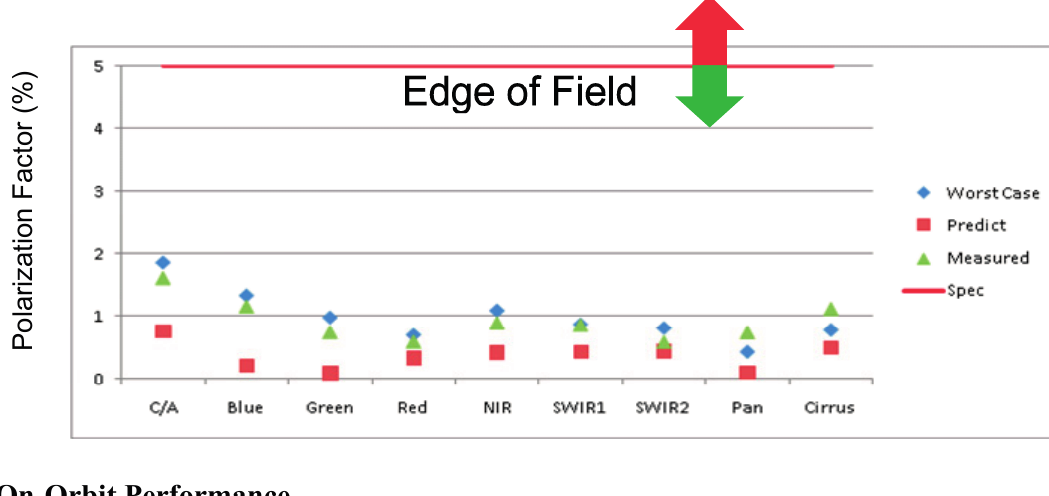
Figure 20. Pre-launch polarization results. These show that OLI’s polarization sensitivity is well below the required 5%. The “predict” and “worst case” numbers come from optical modeling. The measured values are from the instrument level